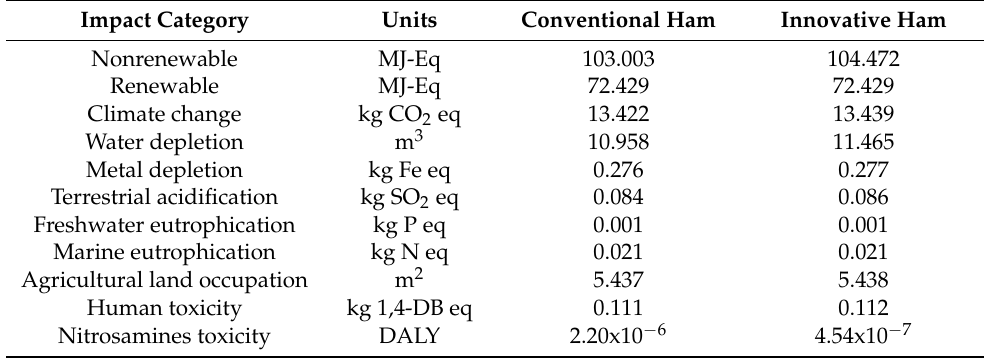
Table 3. Environmental and human health impact of the cooked ham life cycle for conventional and combined innovative processes. DALY: disability-adjusted life